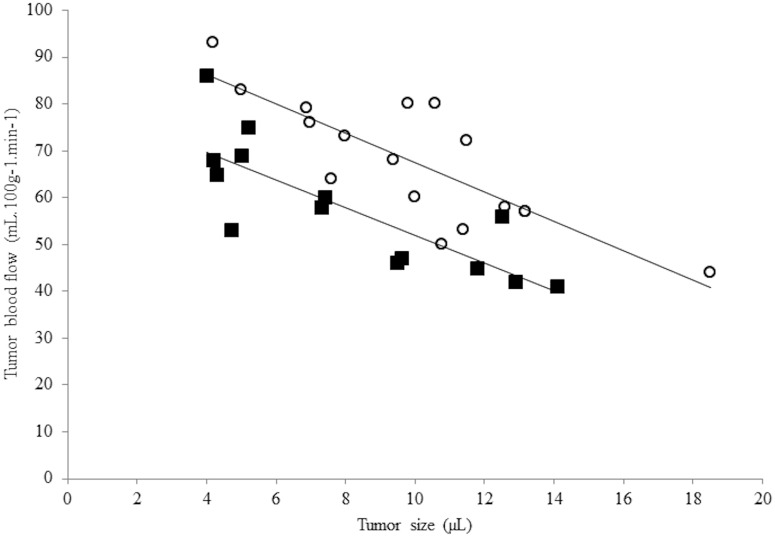
Tumor blood flux as a function of tumor size.This figure illustrates the impact of the tumor size on the tumoral blood flow. Open circles (o) correspond to data acquired in the group arising from the cells initially grown under mild hypoxia (3% O2) and close squares (■) to data acquired in the group arising from the cells initially grown under normoxia (21% O2).